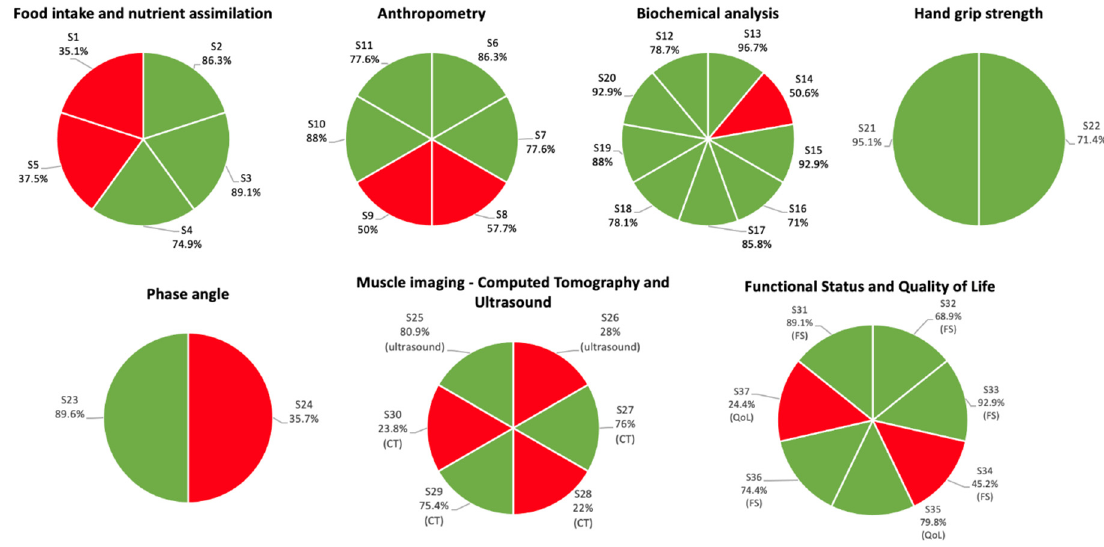
Figure 2. Consensus achieved on each statement is shown by topic. Green indicates consensus, red indicates no consensus. CT, computed tomography; FS, functional status; S, statement; QoL, quality of life.